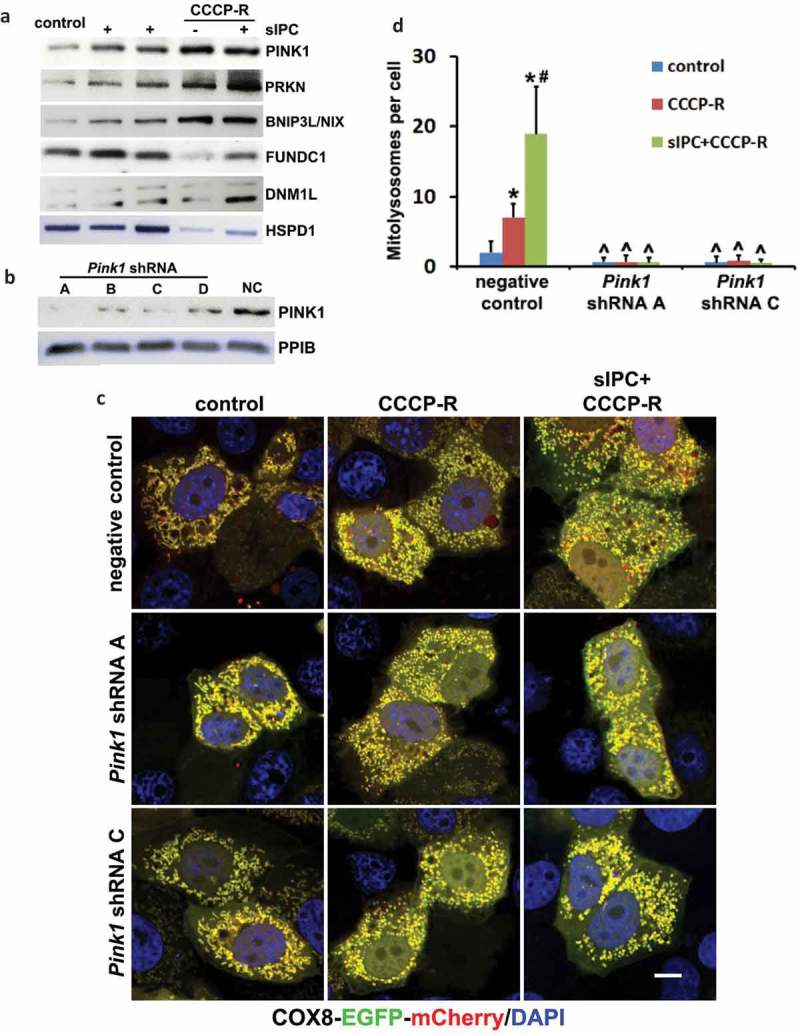
Knockdown of Pink1 inhibits mitophagy flux in CCCP-treated RPTC cells. (a) RPTC cells were subjected to: (1) control; (2) sIPC; (3) CCCP-R; (4) sIPC + CCCP-R. After treatment mitochondrial fractions were collected for immunoblot analysis of multiple mitophagy-related proteins including PINK1, PRKN, BNIP3L/NIX, FUNDC1 and DNM1L. HSPD1, a mitochondrial matrix protein, was used as a loading control. (b) RPTC cells were infected with retroviral Pink1 shRNA constructs (A–D) and a negative control (NC) construct. Upon puromycin selection, stable cells were collected for immunoblot analysis of PINK1. PPIB was used as a loading control. Based on the inhibitory effects, the stable cells (negative control, Pink1 shRNA A, Pink1 shRNA C) were transfected with COX8-EGFP-mCherry and then treated with: (1) control; (2) CCCP-R; (3) sIPC + CCCP-R. Cells were collected for fluorescence microscopy. (c) Representative images of mitolysosome formation. Scale bar: 10 μm. (d) Quantitative analysis of the number of mitolysosomes per cell. Data are expressed as mean ± SD. *, P < 0.05, significantly different from the control group; #, P < 0.05, significantly different from CCCP-R group; ^, P < 0.05, significantly different from the corresponding groups in negative control cells.